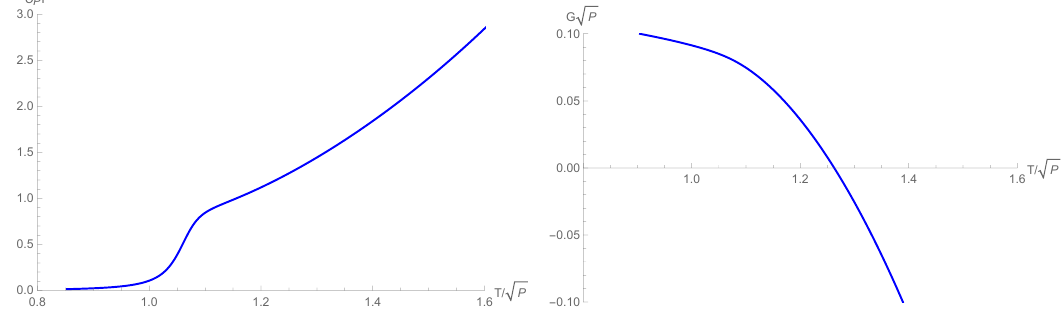
p p P against T= P for a RN black hole in a cavity with Q =